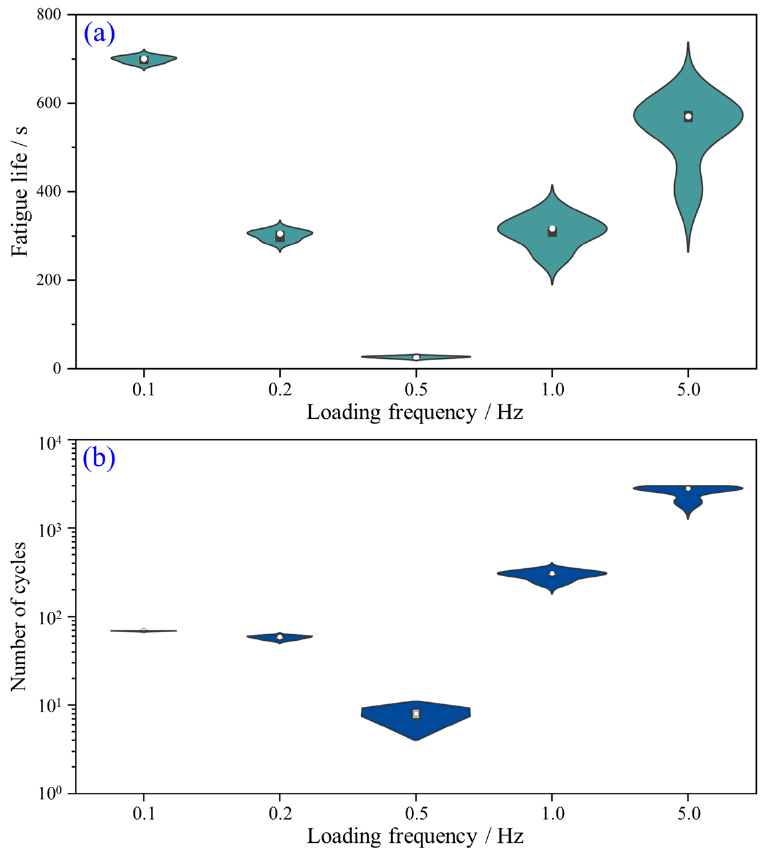
Figure 7. Variations in ( a ) fatigue life and ( b ) number of cycles of YNS sample against loading frequency under CPL condition.